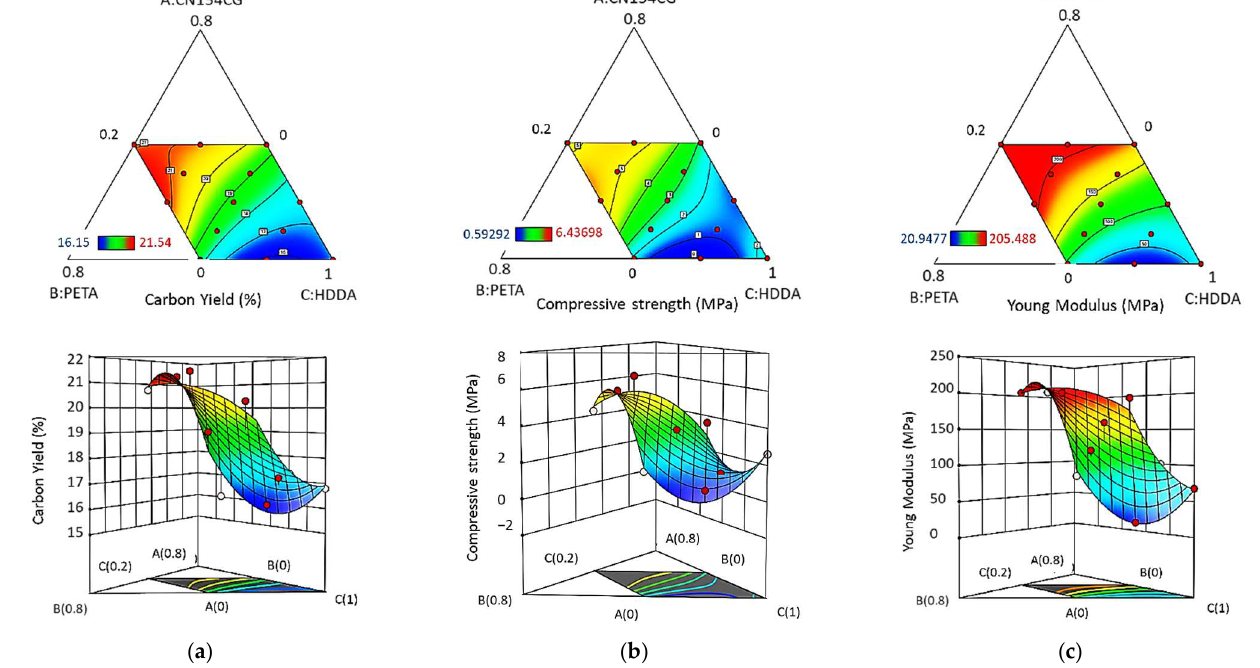
Figure 7. Contour plots ( top ) and surface plots ( bottom ) of the effect of the acrylate ratio on: the ( a ) carbon yield, ( b ) compressive strength, and ( c ) Young’s modulus. The numerical values of the responses increase from dark blue to red.